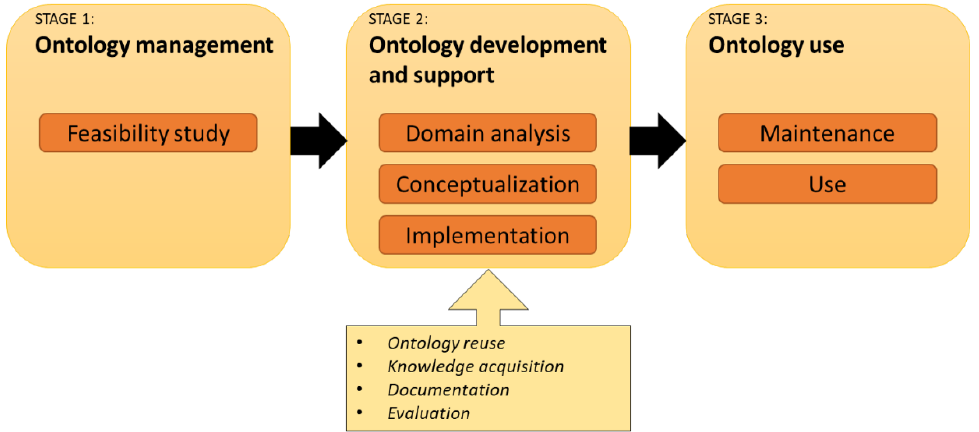
Figure 1. Ontology engineering activities distributed in three stages, each detailed into tasks (according to [21]).